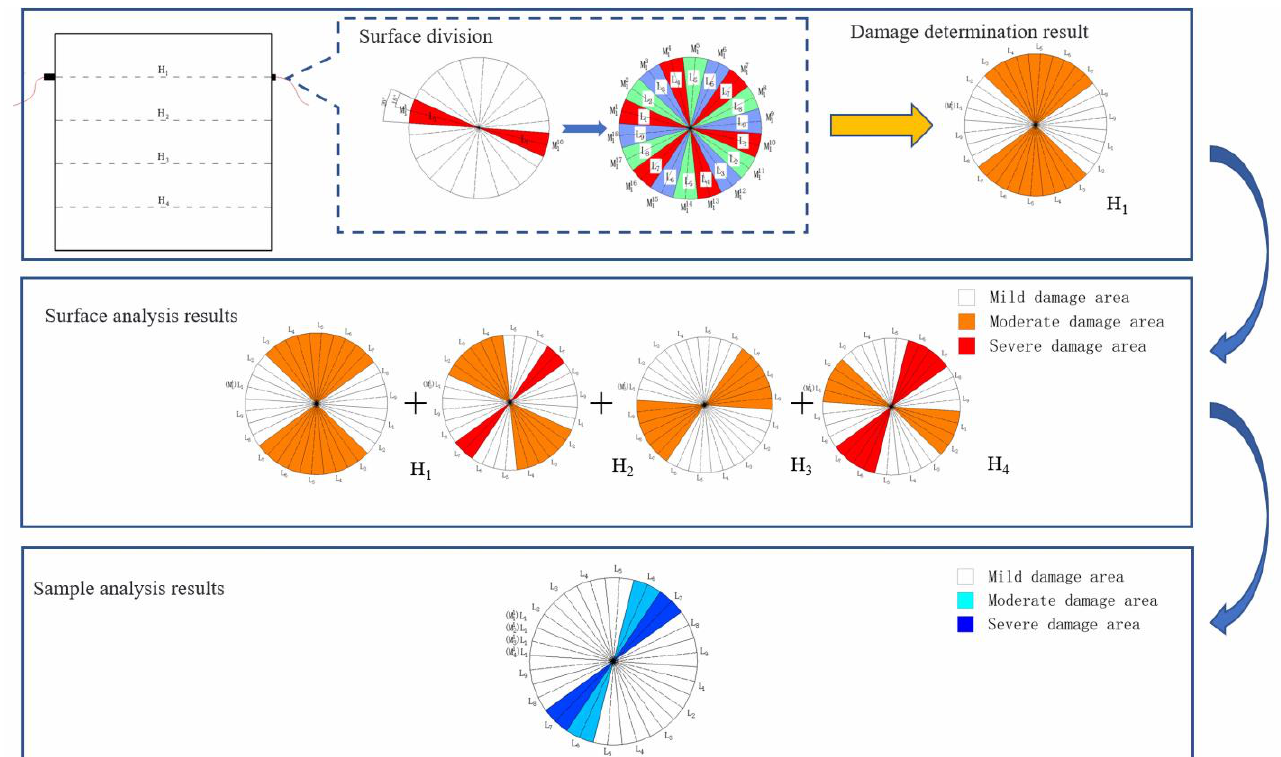
Figure 8. Test and analysis process. The damage region distribution of the measuring surface was determined accord-ing to the damage condition of the measuring line, and the final damage result of the sample was obtained by superimposing the damage condition of each surface.